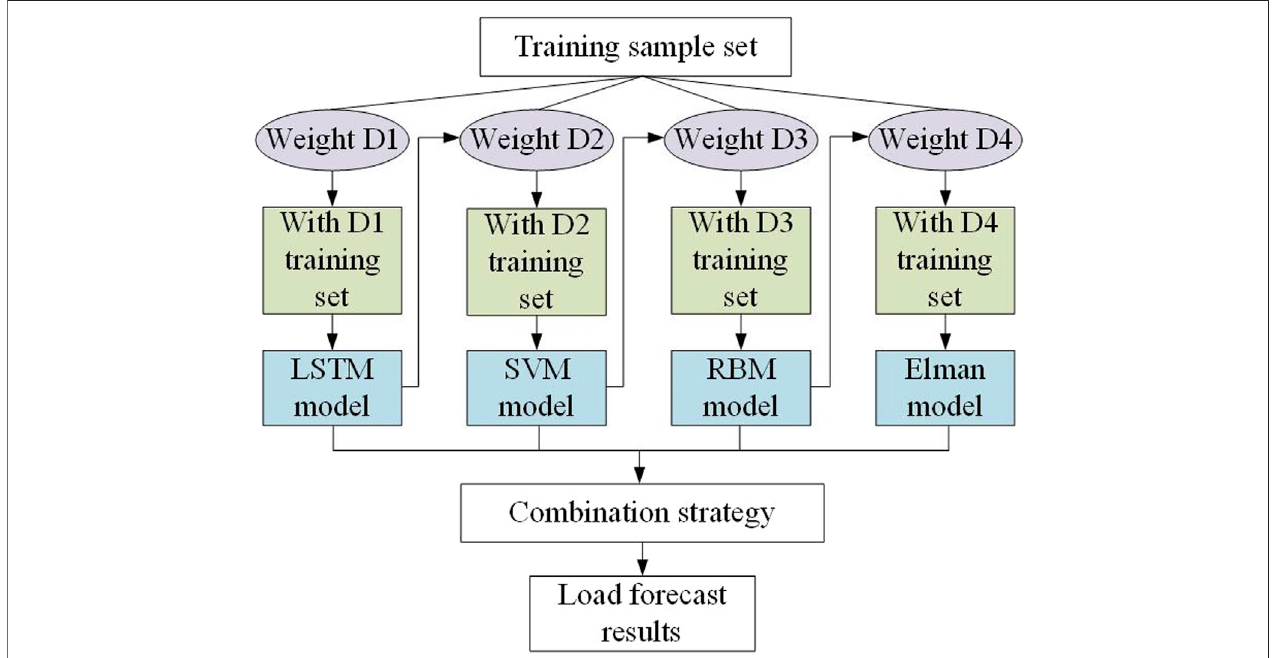
FIGURE 5 | Principle of the octopus-head